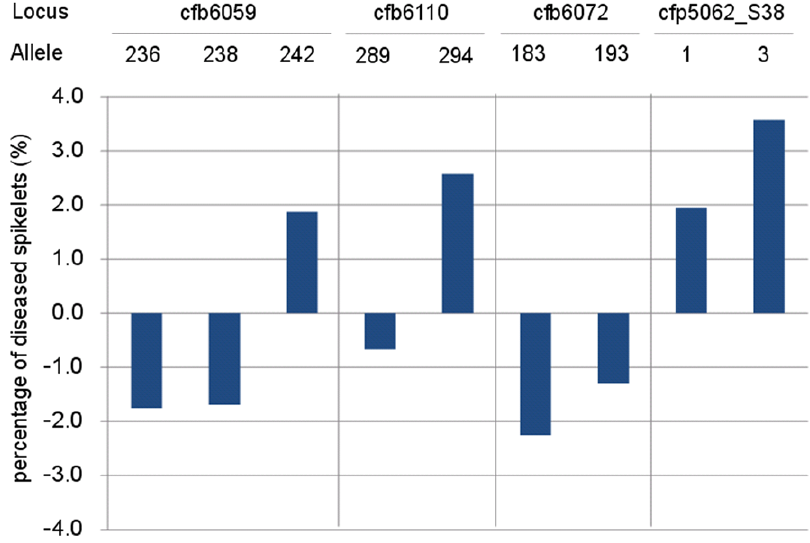
Figure 4. Comparison of allelic effects of four significantly associated loci for PDS (%).